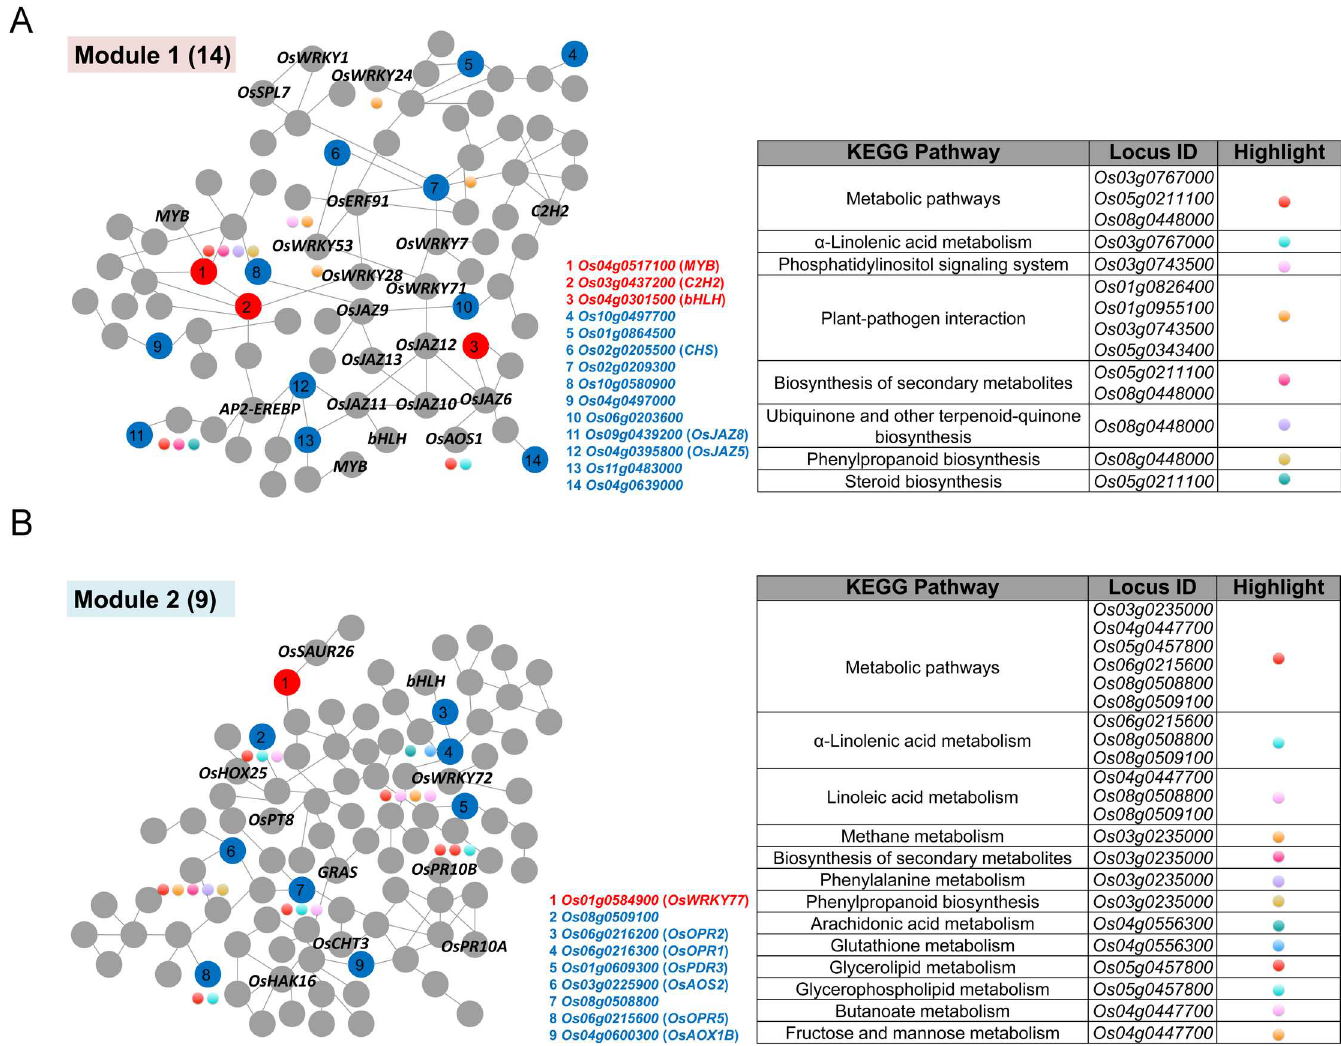
Fig 5. Gene ontology (GO) enrichment analysis of genes up-regulated by high C:low N. The differentially expressed probe sets were analyzedby SEA (singular enrichmentanalysis) using AgriGO, and the comparison is displayedin graphicalmode. Each box contains GO term number, the false discovery rate (FDR) value, GO term and item number associated with the GO term in the query list and backgroundas well as total number of query list and background. The degree of color saturationof a box is positively correlated to the enrichmentlevel of the term (the yellow-to-red represents the term is up-regulated while non-significant terms are shown as white boxes). Solid, dashed and dotted lines represent two, one and zero enrichedterms at both ends connected by the line, respectively. (A) Biologicalprocess category analysisof high C: low N up-regulated genes; (B) Molecularfunction category analysis of high C:low N up-regulated genes; (C) List of screened genes in “fatty acid biosynthesis”, “defense response” and “oxidoreductase activity” categories with p -values.